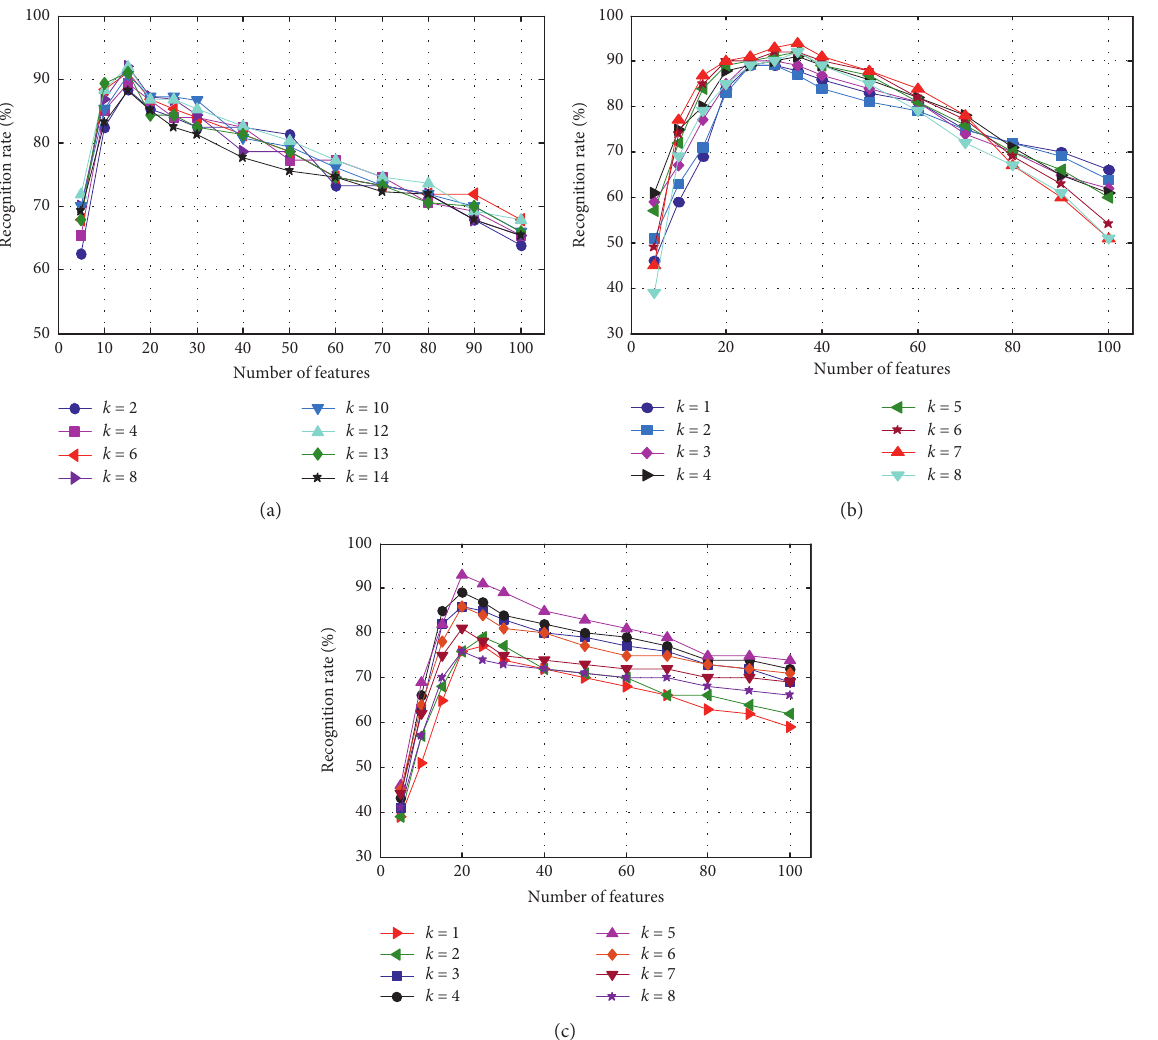
Figure 3: Recognition rate with different number of nearest neighbors and reserved features. (a) Experiment result based on Yale-B face database. (b) Experiment result based on ORL face database. (c) Experiment result based on UMIST face